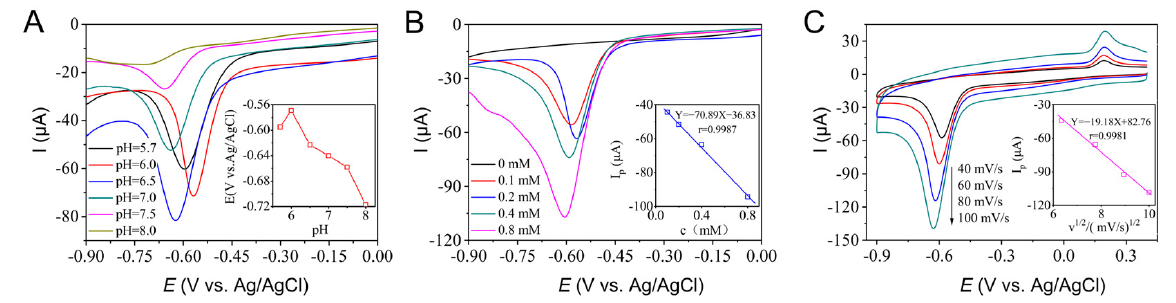
Figure 7. Reduction peak curves at different pH ( A ), p ‐ NP concentration ( B ), and scanning rate ( C ) of P ‐ NDCX ‐ 1.0/GCE.